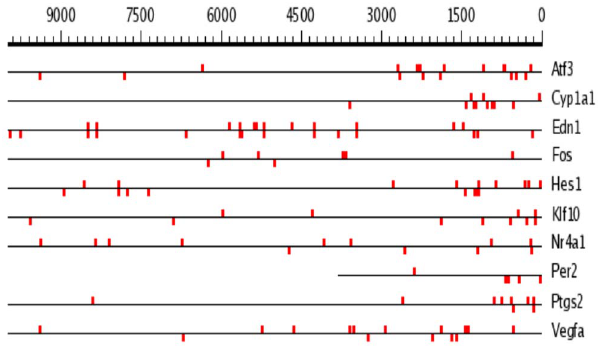
Figure 9. Position of (A/G)CGTG consensus within 1,500 bp 5 9 - UTR of genes listed in Table 5.